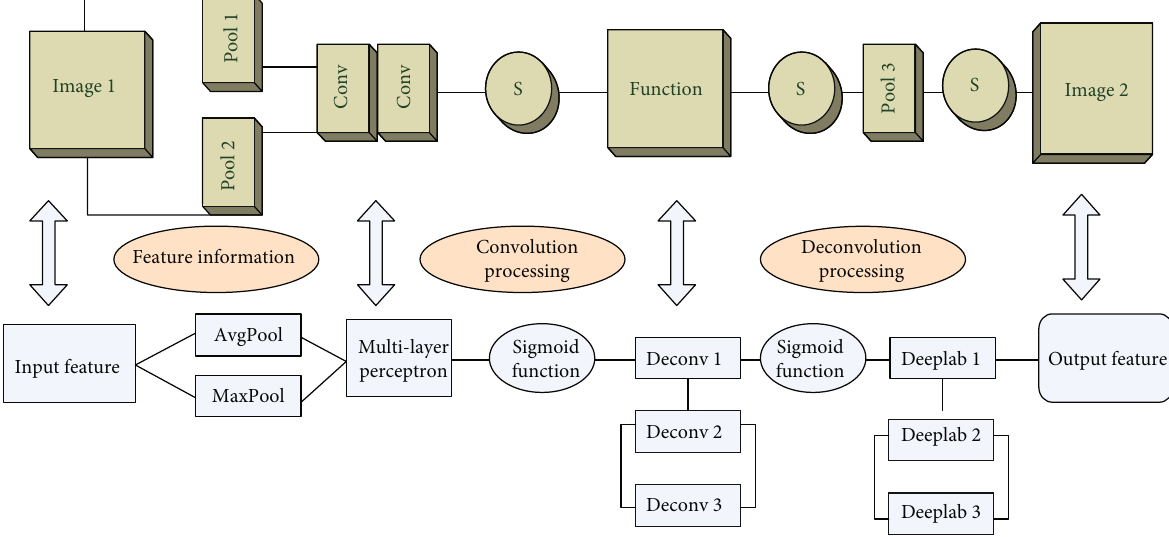
Figure 2: Flowchart of the image light highlighting